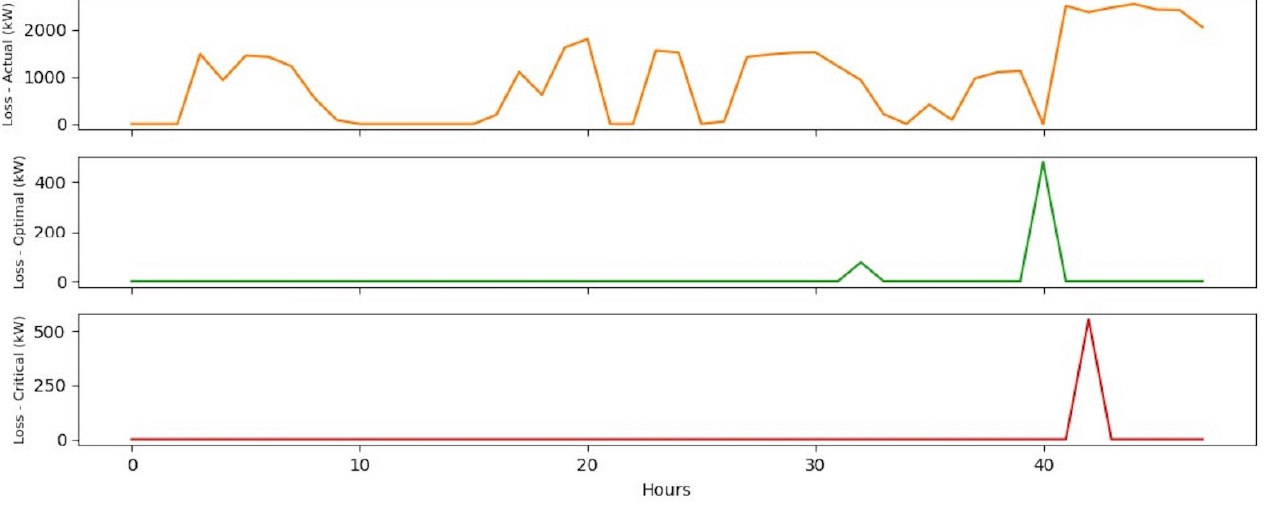
Figure 4. Loss occurrence and value in Summer.